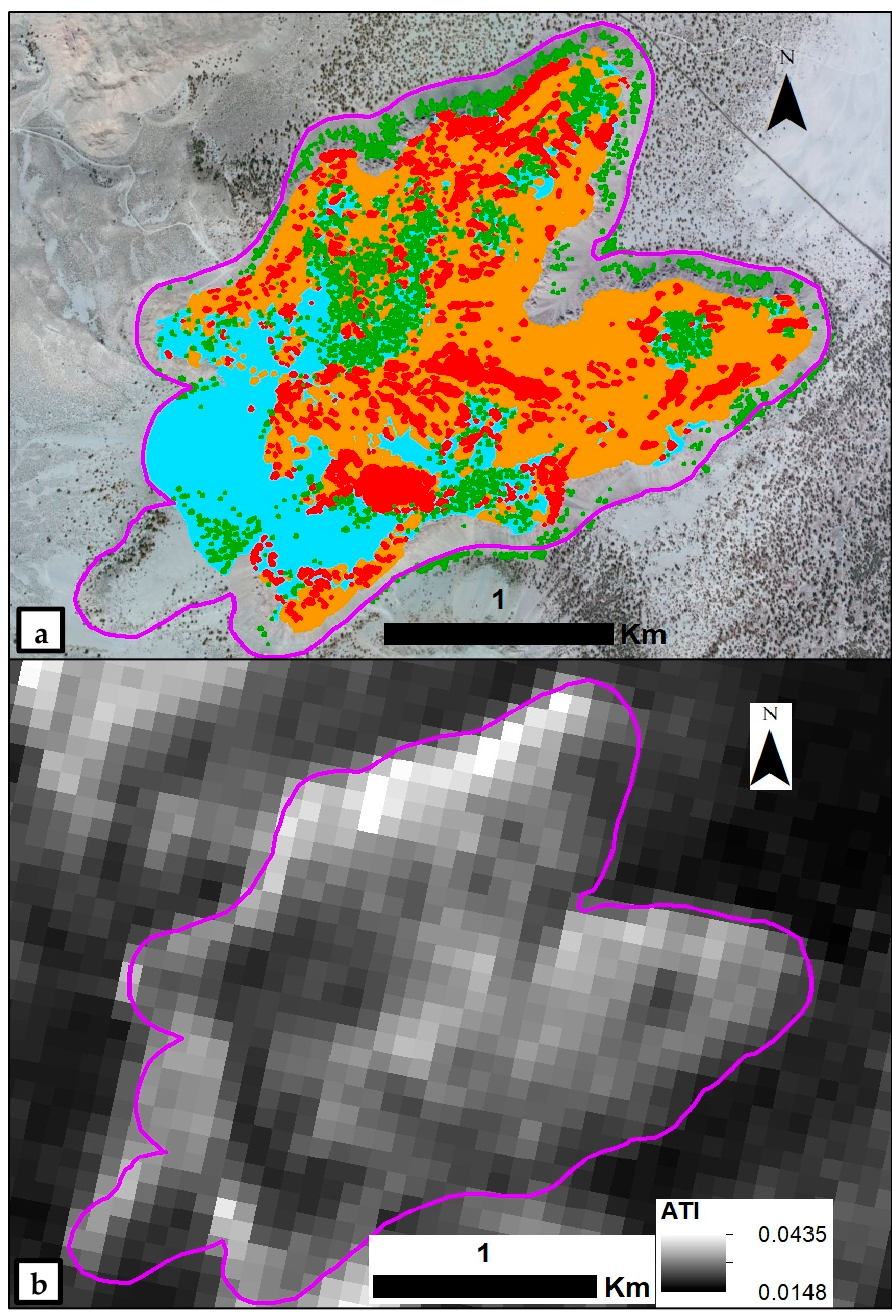
Figure 7. ( a ) Category distributions (red = coarse, orange = moderate, blue = fine, and green = trees) overlain on WorldView-2 data (Courtesy of DigitalGlobe Foundation). Categories are derived from WorldView-2 panchromatic data. ( b ) Calculated ATI values from ASTER VNIR and TIR data displaying the variability in the study area. The extents of the North Coulee are defined in purple.